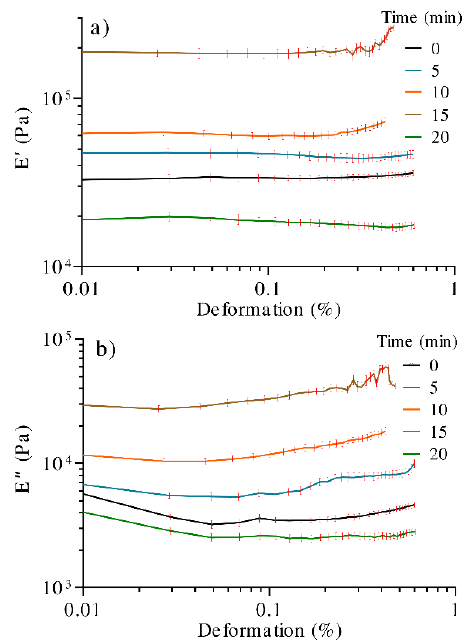
Figure 5. DMA curves of hydrogels treated with different times of UV radiation. ( a ) Storage modulus (E ′ ) and ( b ) loss modulus (E ″